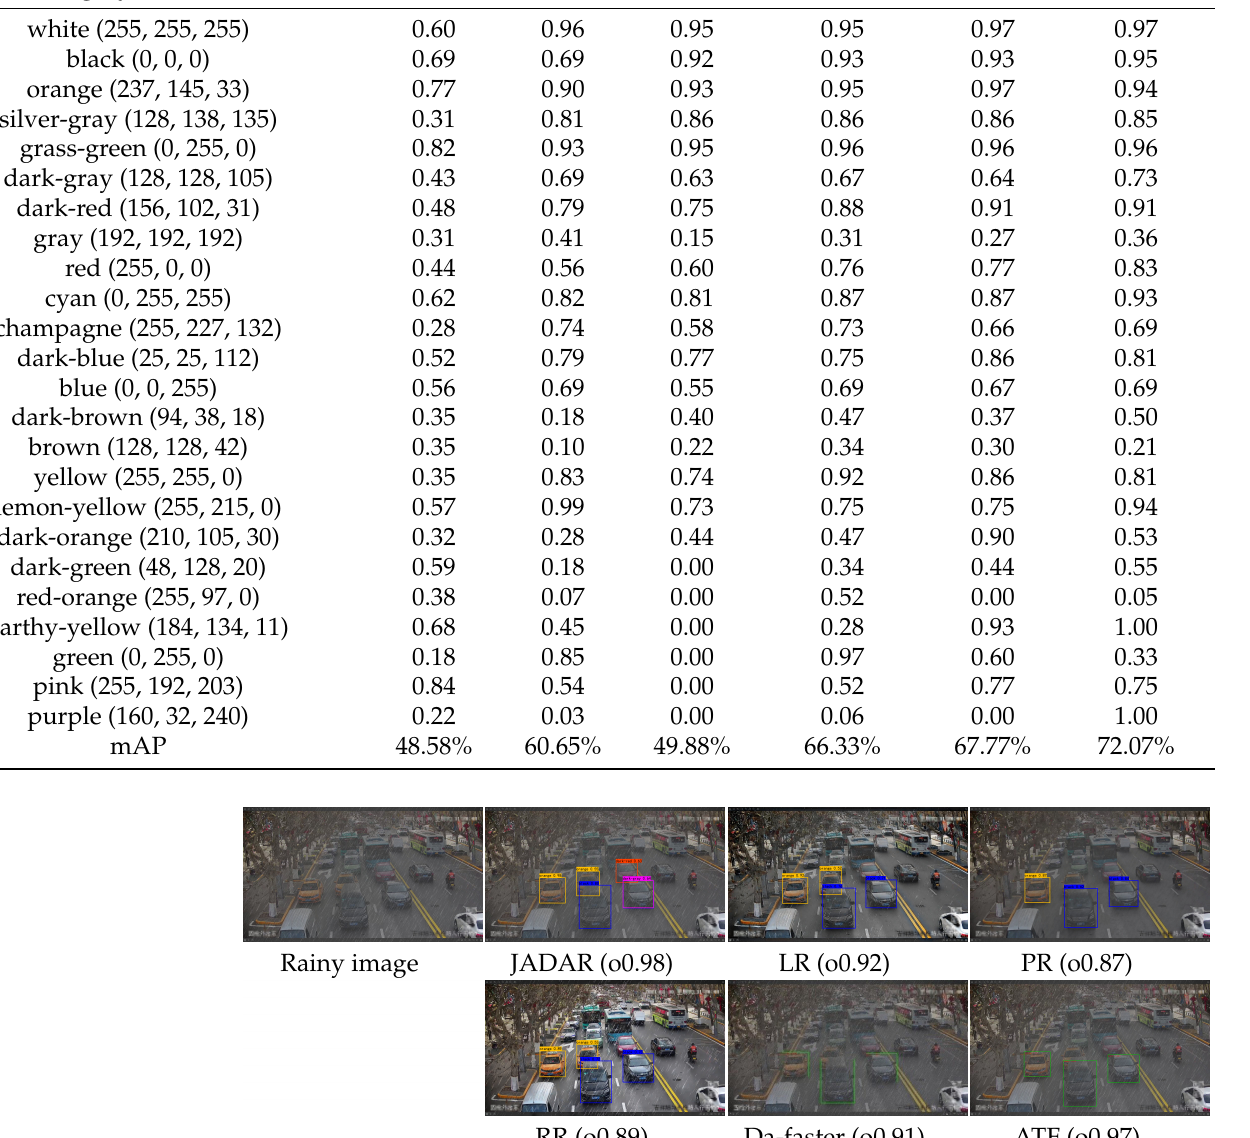
Figure 10. Example 2 of test results of JADAR and two-stage methods and domain-adaptation methods on the Rain Vehicle Color-24 test